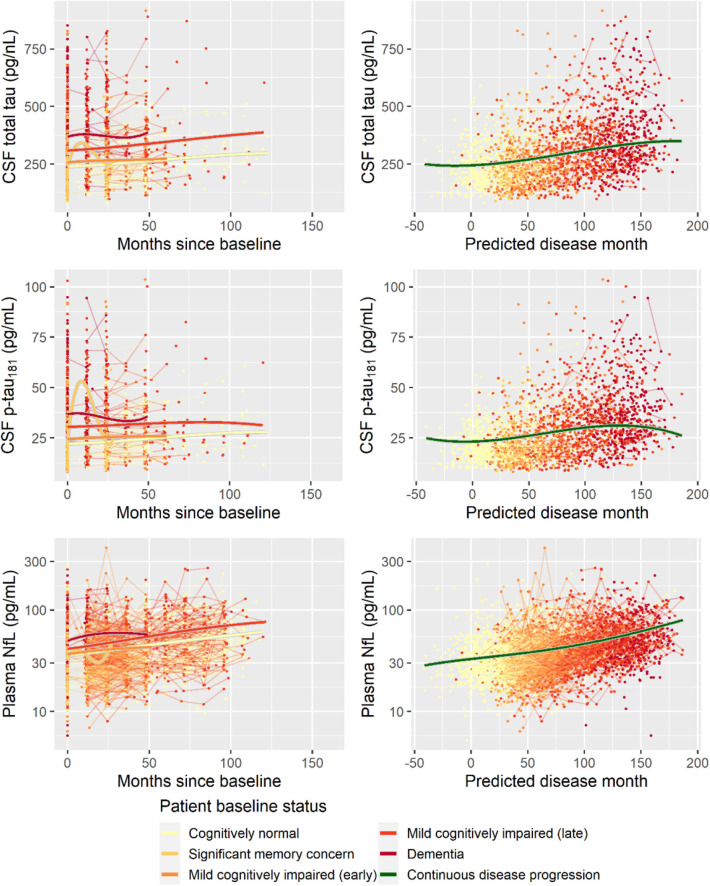
Data and estimated biomarker trajectories for total tau (CSF), p-tau181 (CSF), and NfL (plasma). Left column shows results when allowing different trajectories for the five baseline groups; right column shows the results when requiring a single trajectory over predicted disease time. Note that the oscillations for the significant memory concern group occur during time periods where no data were collected on the respective biomarkers.